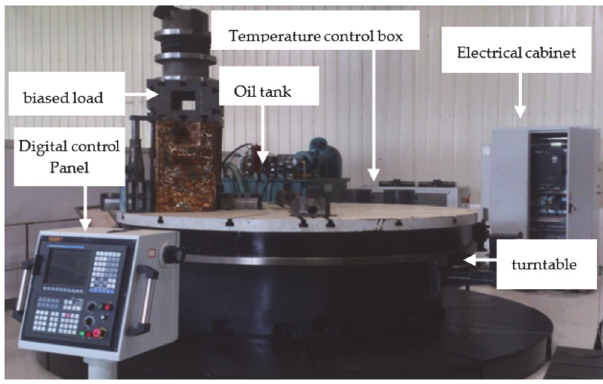
Figure 6. Heavy duty hydrostatic turntable test system.